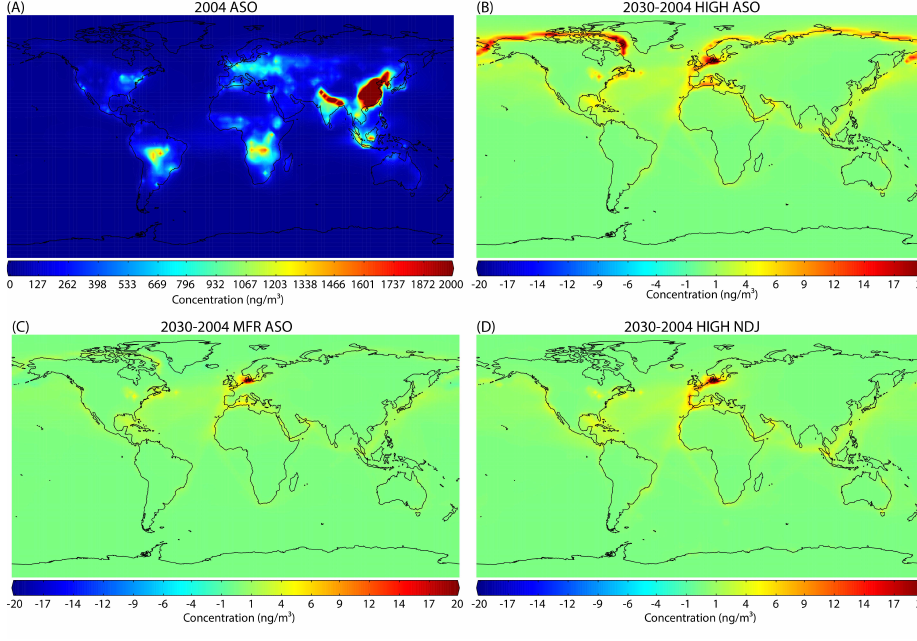
Fig. 4. Same as Fig. 3 for BC (ngm − 3 ) .